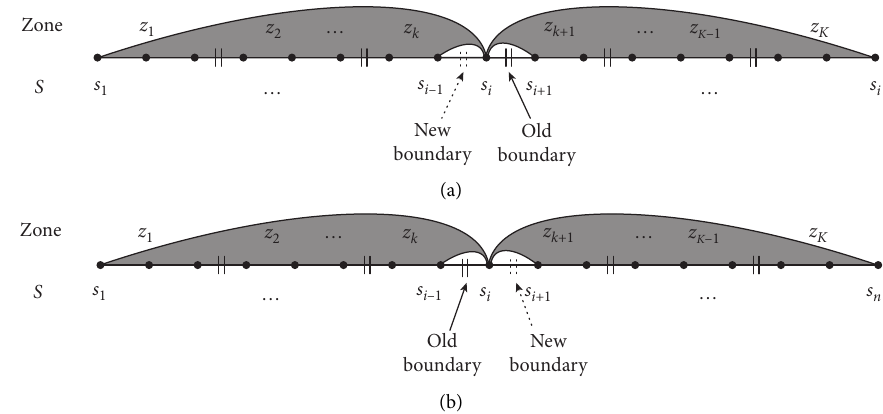
Figure 1: The range of the affected passengers in the moving operation. (a) The range of the affected passengers in the left-moving operation. (b) The range of the affected passengers in the right-moving